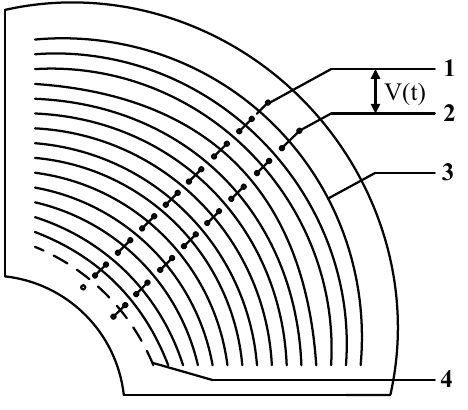
Figure 4. Structure of voltage sensor. 1. Electrode 1; 2. Electrode 2; 3. Annular electrode on the positive side; 4. Annular electrode on the reverse side.